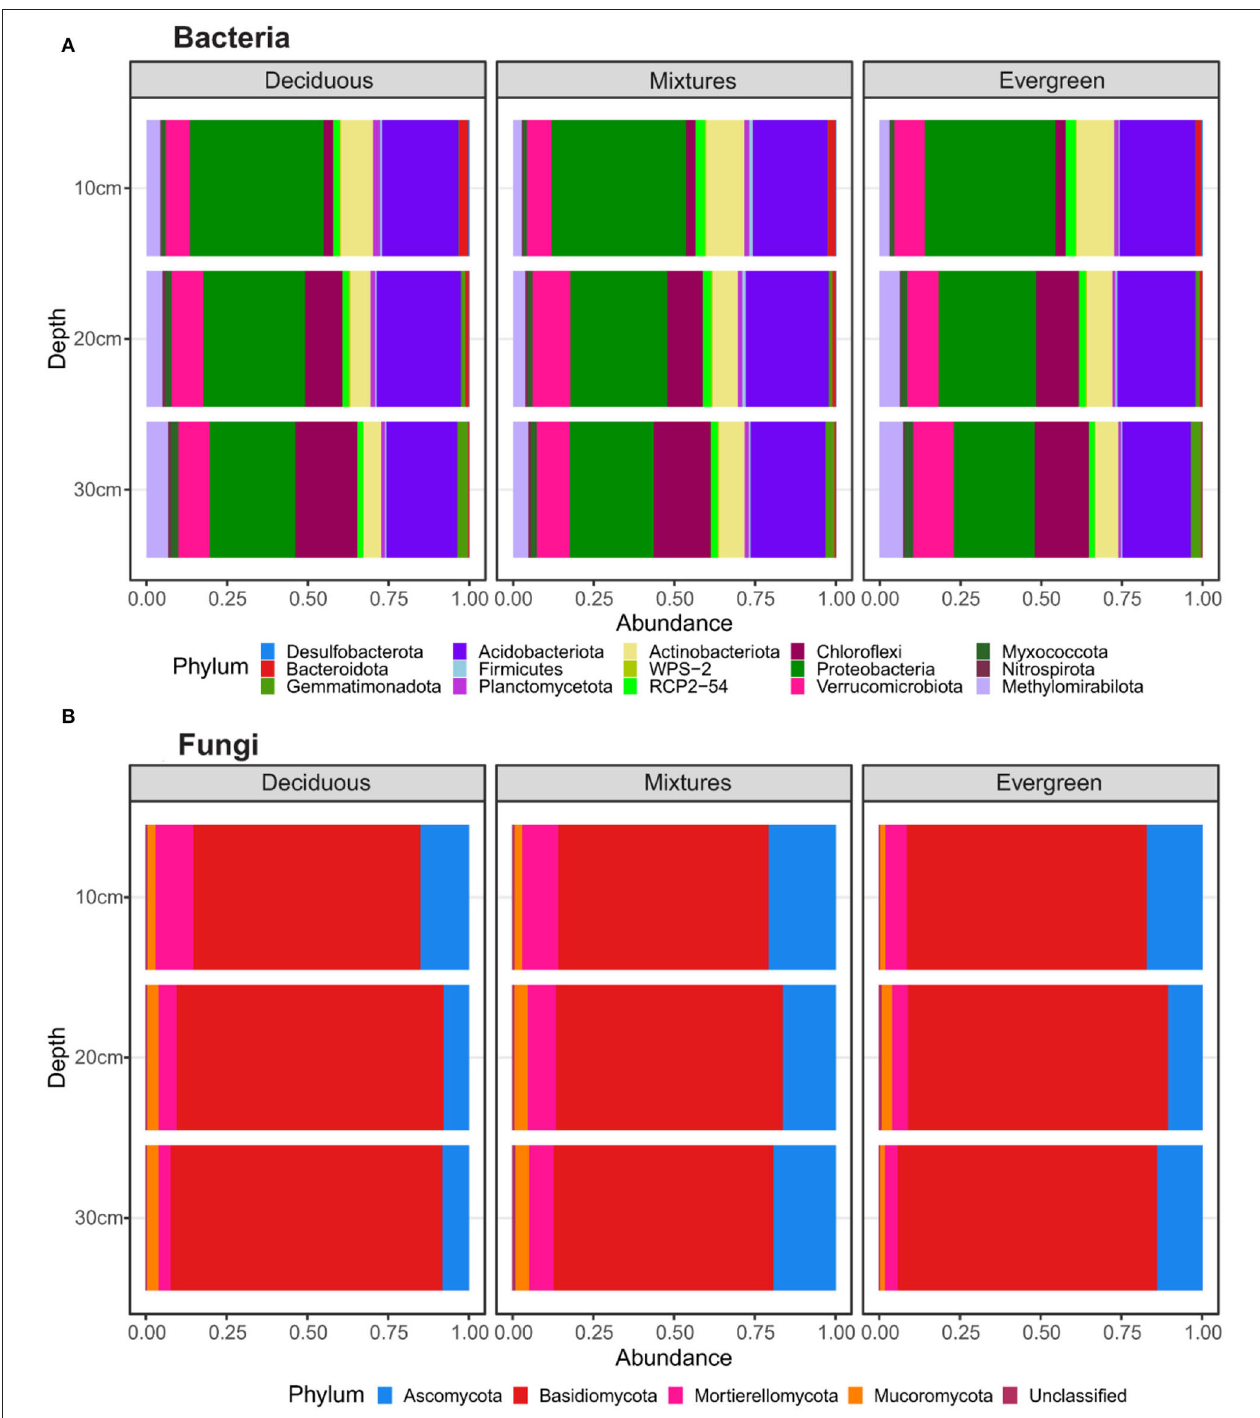
FIGURE 1 | Relative abundances of (A) bacterial and (B) fungal phyla in relation to forest composition, split between deciduous, mixture, and evergreen forests (vertical panels), and soil depths. The data represent values of taxa with a relative abundance higher than 0.1 (for statistical details see Supplementary Tables 3 , 4 ).